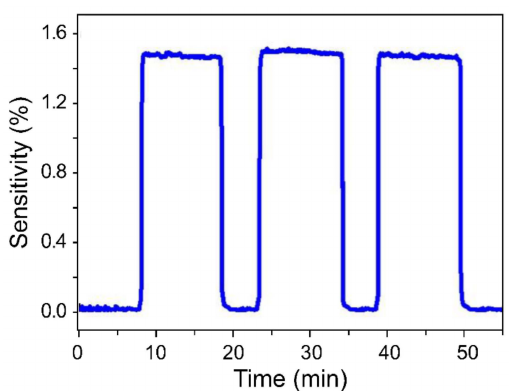
Figure 5. Sensor-response repeatability at constant H 2 concentration. The cycle included a response time of 10 min and a recovery time of 5 min and was repeated five times at 5